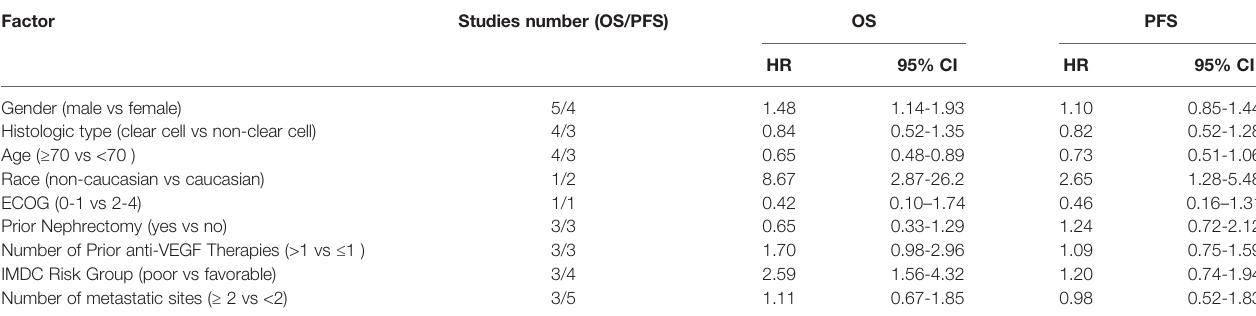
TABLE 2 | The association between other risk factors and overall survival and progression-free survival of patients with renal cell carcinoma treated with immunotherapy.